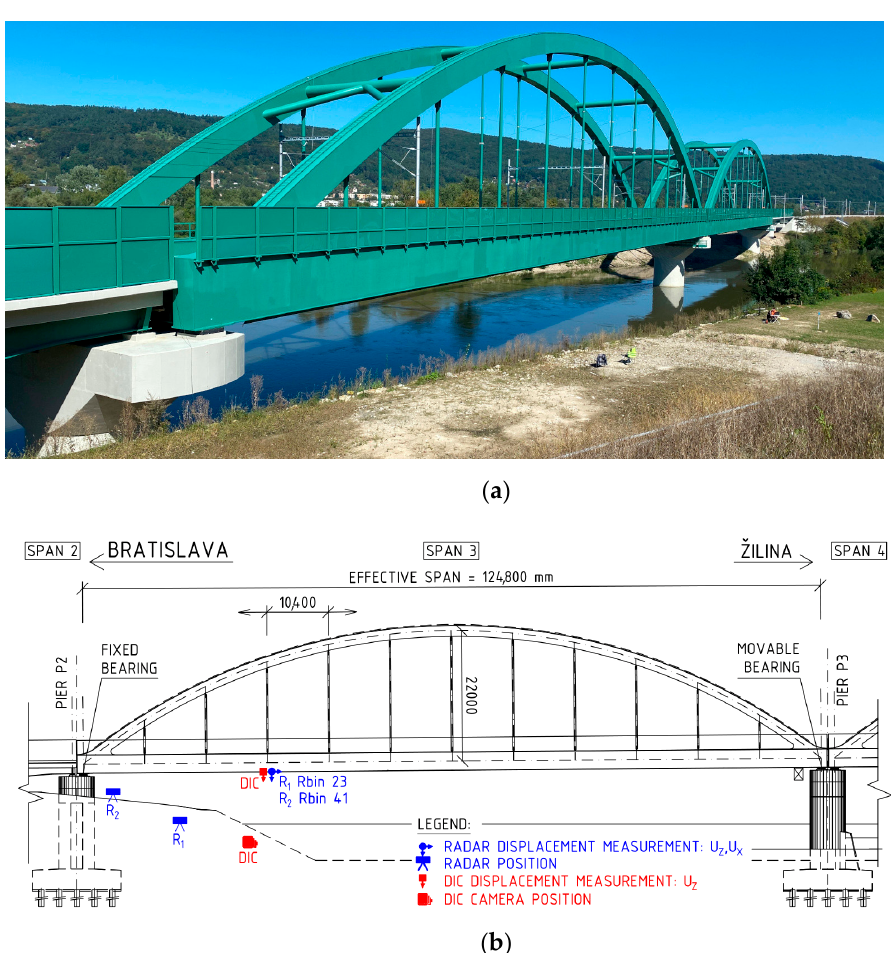
Figure 17. Side view on the analyzed superstructure BS2 ( a ) photo; in the background there is the superstructure BS3; ( b ) schematic with marked positions of DIC target, Rbins, radars, and DIC cam- era.